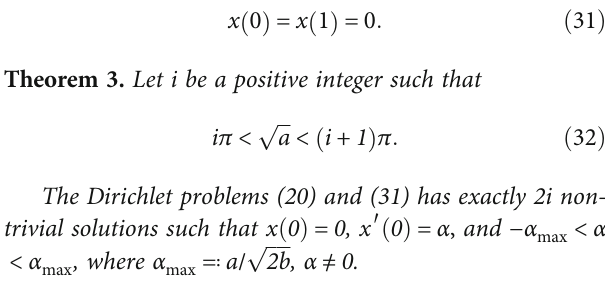
Figure 9. In the same picture, an additional solution of the ð α ≈ 16 : 4802 Þ is shown. problem with α < α < α homoclinic 0 The value α corresponds to the intersection point of a tra- 0 jectory going to the critical point (right of the homoclinic region) with the x ′ axis. For the negative initial conditions − α < α < 0 , there are two solutions to the problem. homoclinic